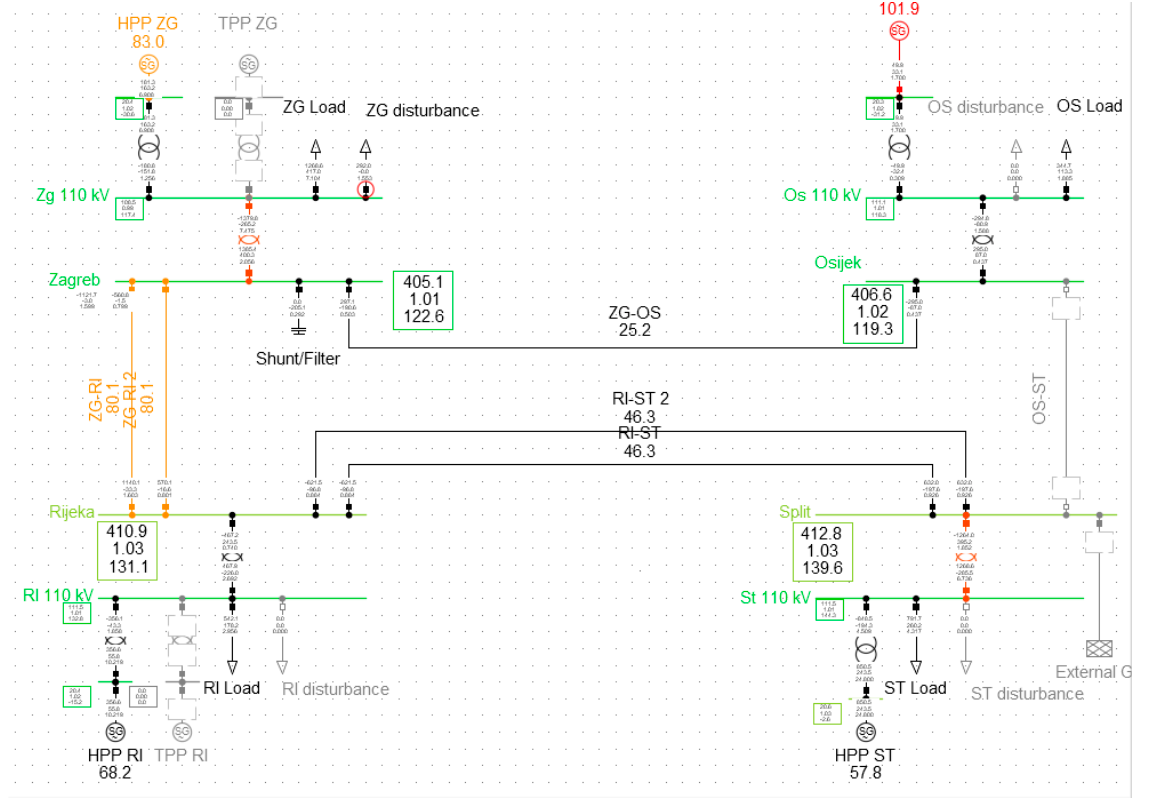
Figure 11. Line loadings and voltage profile with increased transmission capacities between north and south.